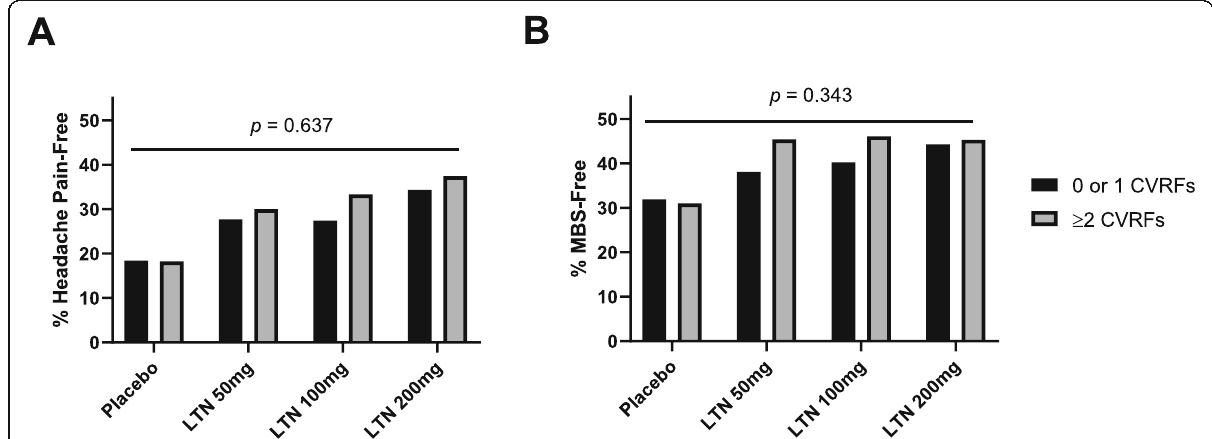
Fig. 1 Proportion of patients in the mITT population who were headache pain-free ( a ) and MBS-free ( b ) at 2 h by the degree of cardiovascular risk. CVRF cardiovascular risk factor, LTN lasmiditan, MBS most bothersome symptom, mITT modified Intent-to-Treat. Note: p values are for treatment-by-subgroup interaction, based on logistic regression with terms for study, subgroup, treatment, and treatment by-subgroup in the